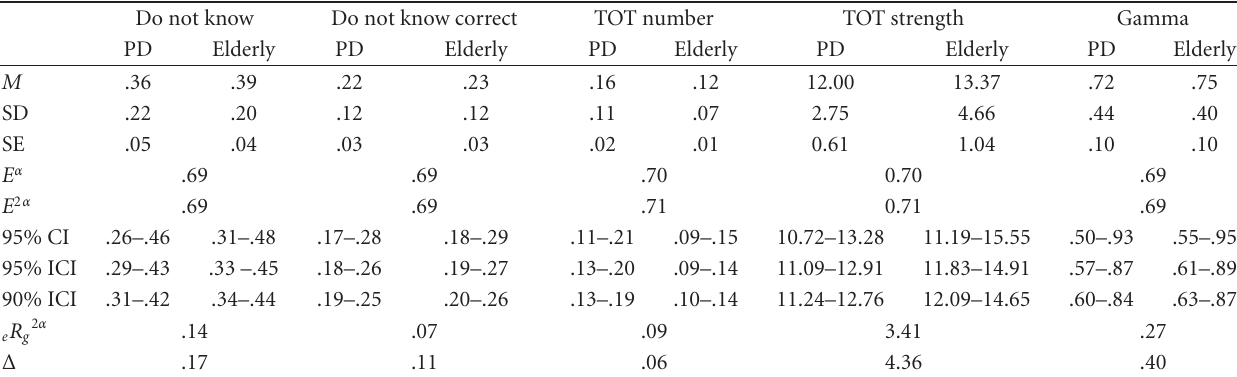
Table 3: Shrinkage factors ( E α and E 2 α ), confidence intervals (CI), inferential confidence intervals (ICI), e R g 2 α , and Δ for metamemory